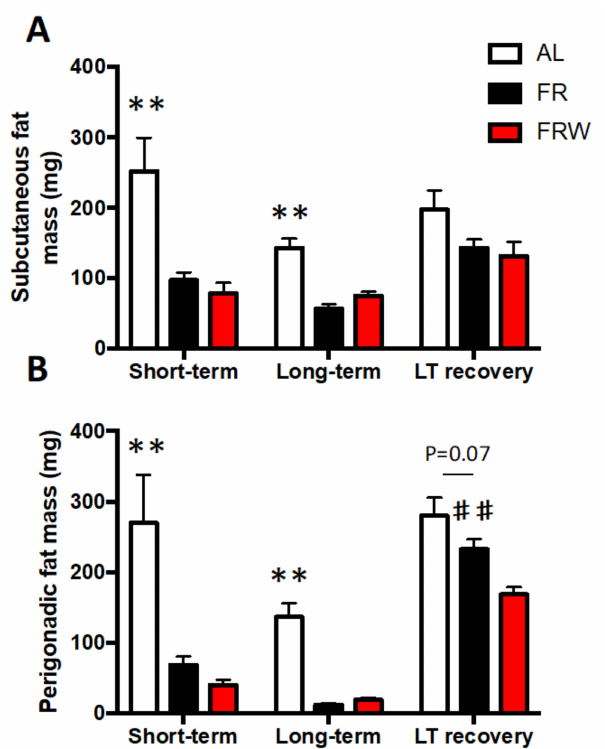
Figure 3. Adipose tissue weight. ( A ) Subcutaneous fat mass and ( B ) perigonadic fat mass weighed in the three protocols: short-term, long-term, long-term (LT) and nutritional recovery. AL: ad libitum ; FR: food restriction; FRW: food restriction and wheel. Data represent mean ± SEM ( n = 6–8 per group); ** p < 0.01 AL vs. FR; ## p < 0.01 FR vs.